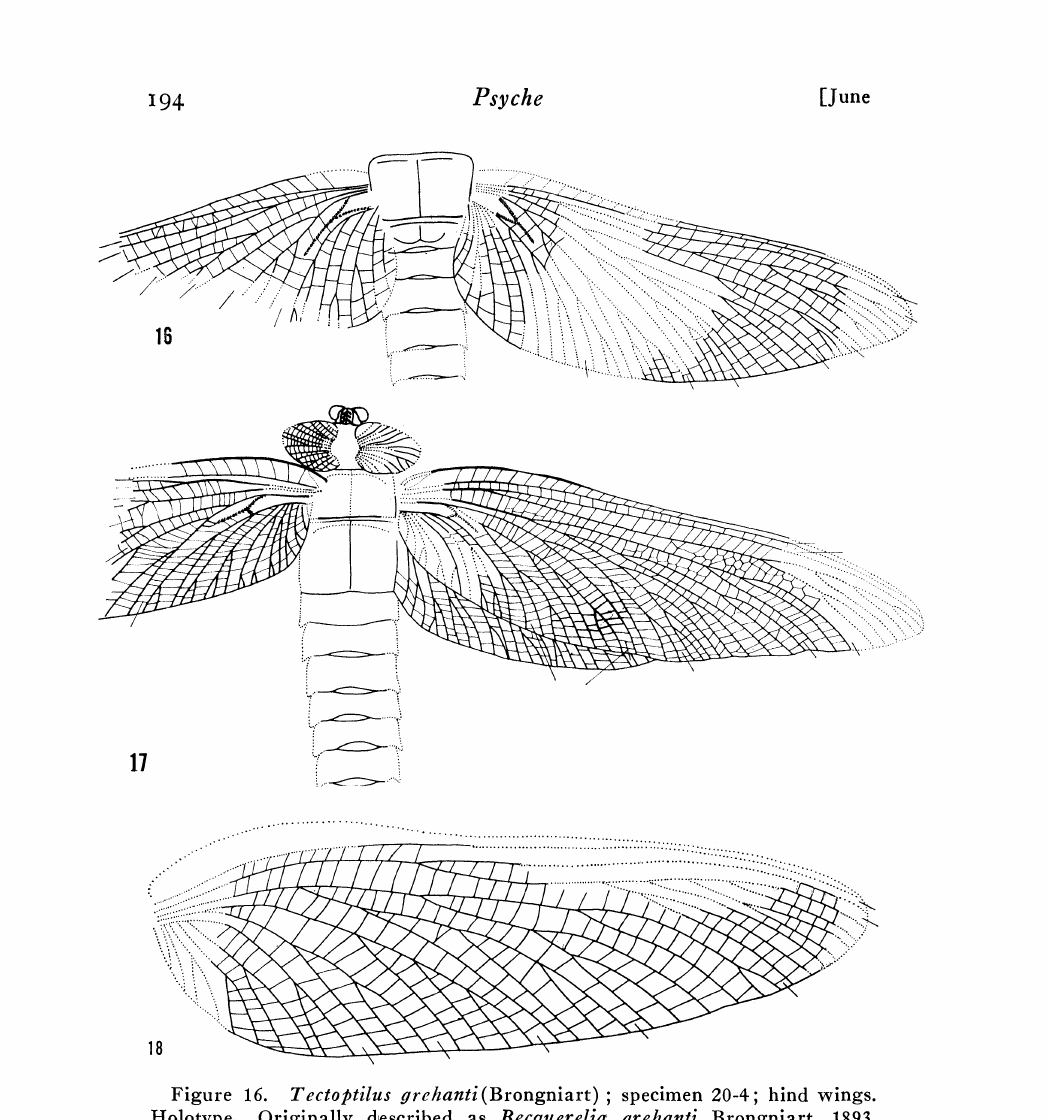
Figure 16. Tectoptilus grehanti(Brongniart); specimen 20-4; hind wings. Holotype. Originally d,eseribed as Becquerelia grehanti Brongniart, 1893. Figure 17. Tectoptilus grehanti (Brongniart) undeseribed specimen also in collection of Paris Institute. Figure 18. Spiloptilus ramondi (Brongniart) specimen 19-14; fore wing.